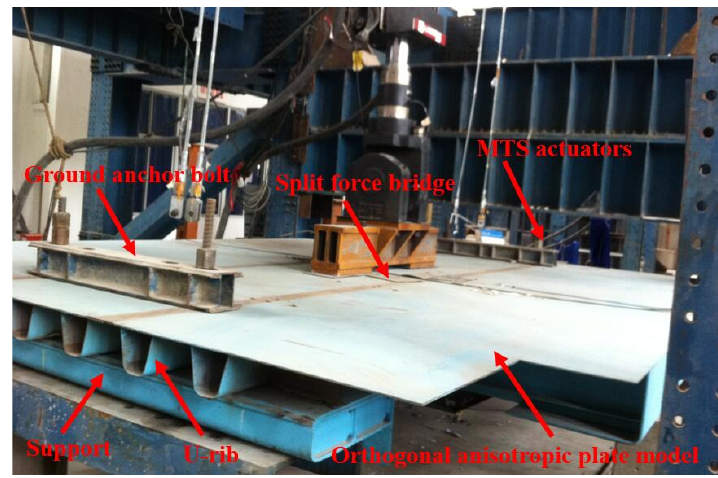
Figure 1. Fatigue test model.